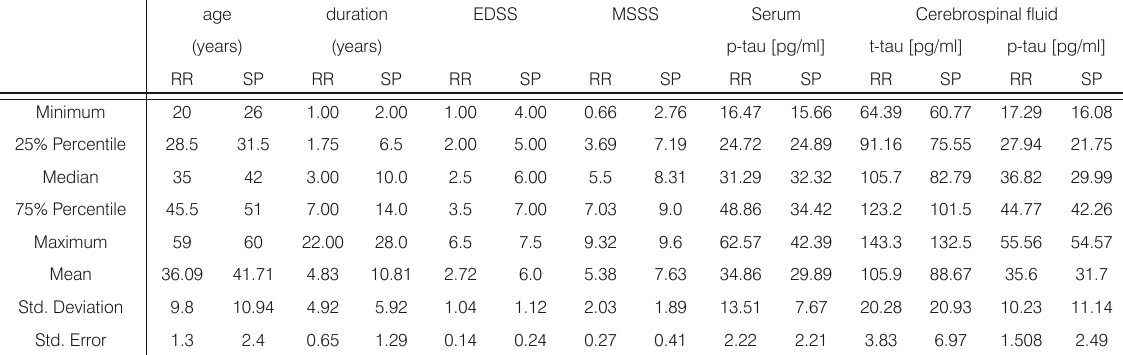
Table 4. Significant differences in the study population with respect to MS type.